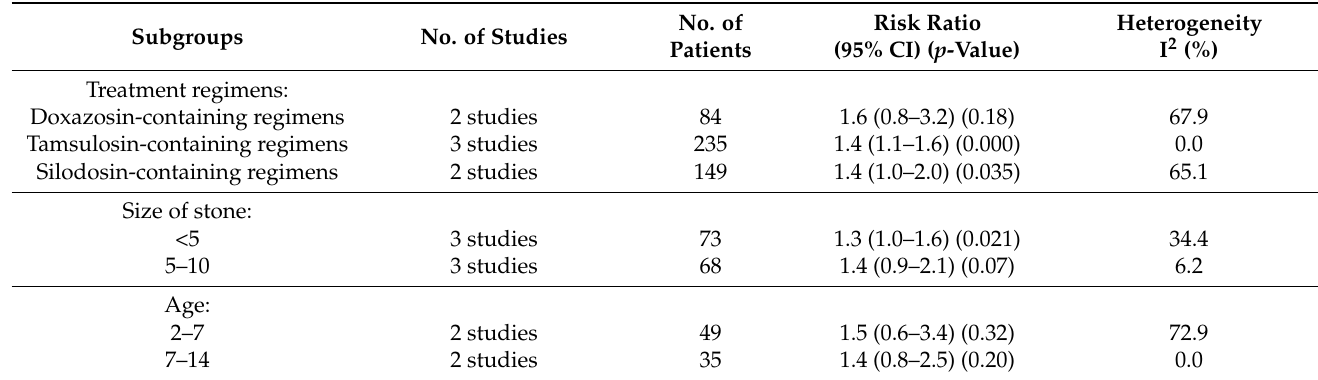
Table 2. Pooled risk ratios for the stone expulsion rate among subgroups of treatment regimens, sizes of stones, and ages of children.